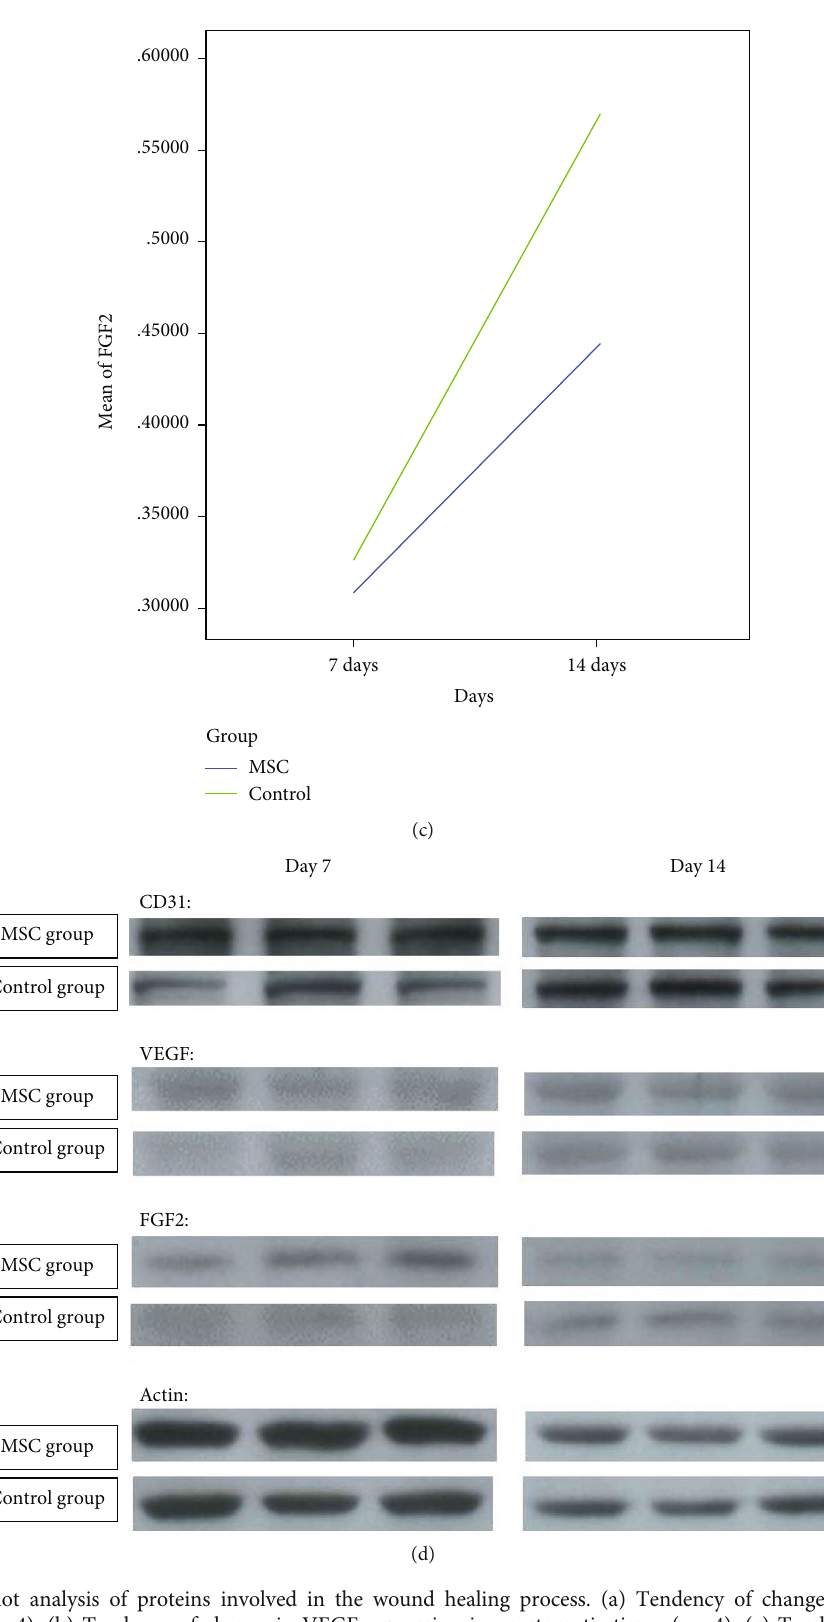
Figure 4: Western blot analysis of proteins involved in the wound healing process. (a) Tendency of change in CD31 expression in anastomotic tissue ( n = 4 ). (b) Tendency of change in VEGF expression in anastomotic tissue ( n = 4 ). (c) Tendency of change in FGF2 expression in anastomotic tissue ( n = 4 ). (d) Representative images for the Western